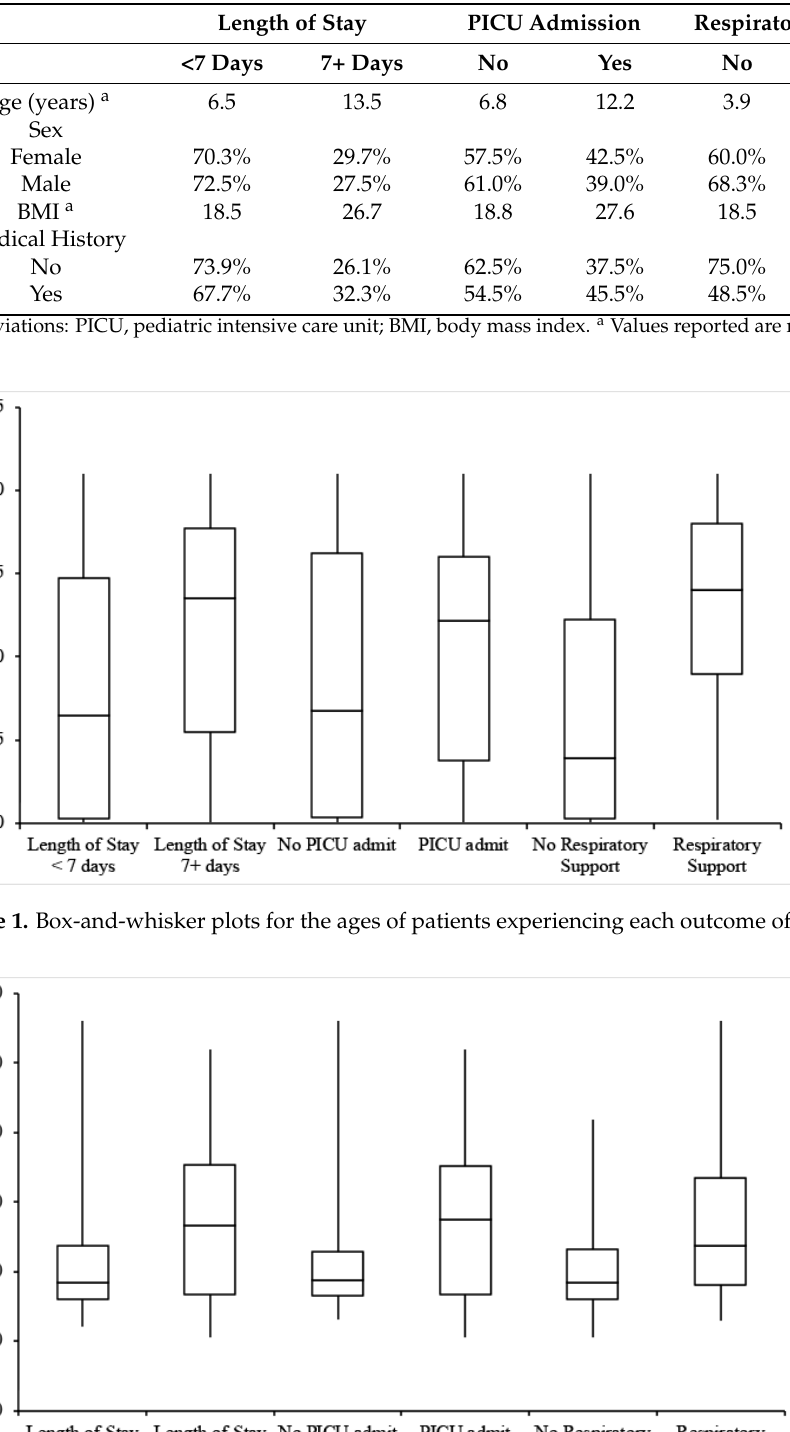
Table 3. Descriptive statistics for each outcome of interest.